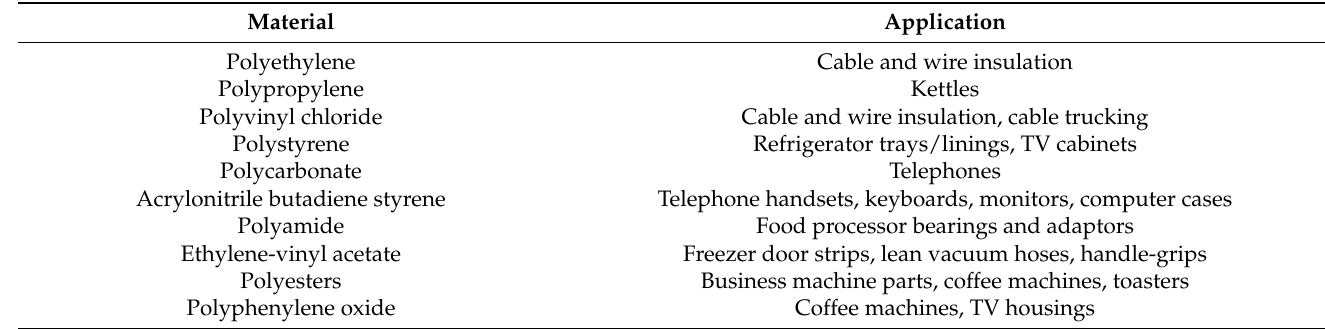
Table 2. Application of thermoplastic with electrical system.